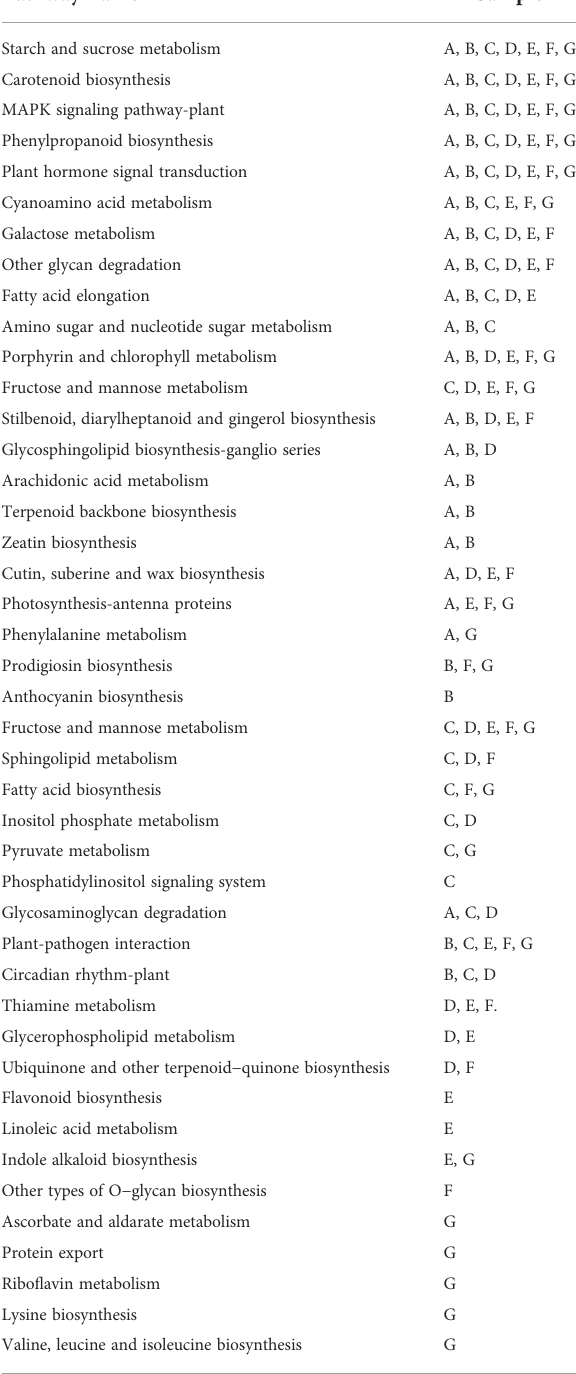
TABLE 4 KEGG enrichment analysis of DEGs across genotypes and developmental stages in tree